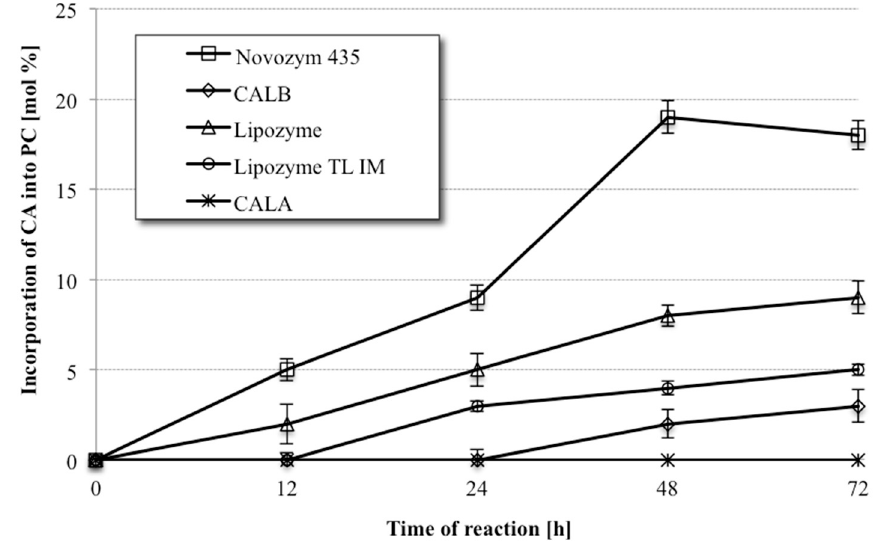
Figure 2. Enzyme screening for acidolysis of egg yolk phosphatidylcholine (PC) with citronellic acid (CA) (reaction conditions: 1:30 PC/CA molar ratio, enzyme load 20% ( w / w ), toluene 2 mL, temperature 30 °C).